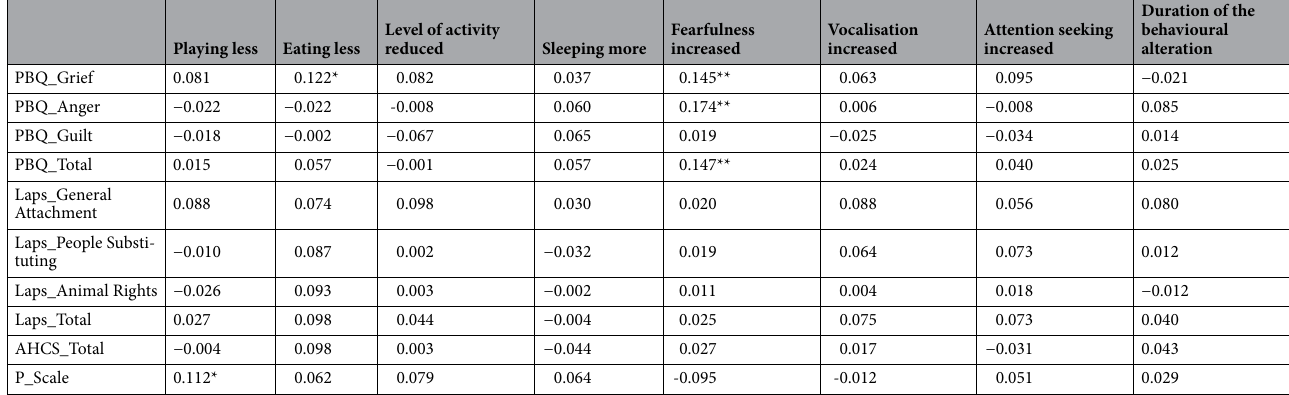
Playing less Eating less